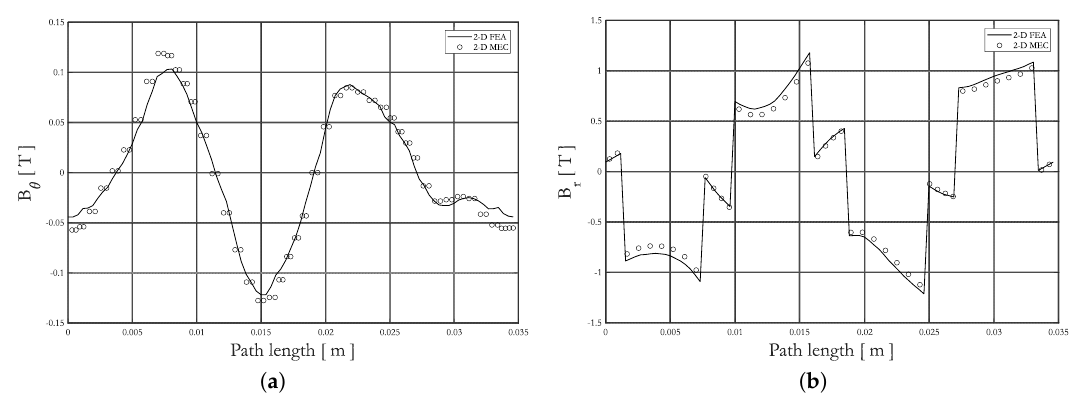
Figure 10. Waveform of B in the rotor air-gap: ( a ) tangential, and ( b ) radial component.